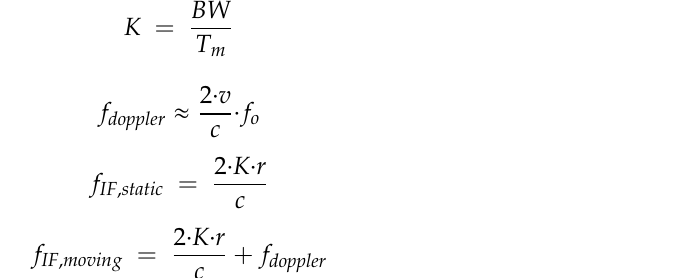
Figure 1. Typical architectures of analog baseband: ( a ) low-pass filter (LPF)-first topology; ( b ) programmable gain amplifier (PGA)-first topology.